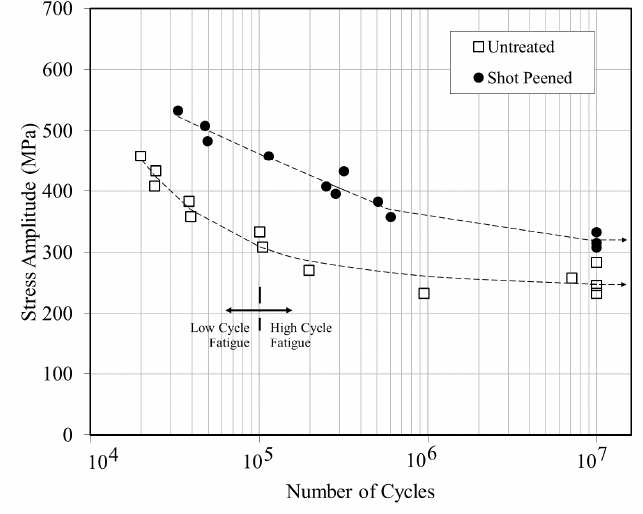
Figure 12. Fatigue stress amplitude versus number of cycles, S–N diagram of untreated and shot ‐ peened PTA-SFFF Ti–TiB samples. Shot-peened samples performed significantly better than untreated samples, being able to sustain higher stress amplitudes at similar sample life cycles in comparison with the untreated